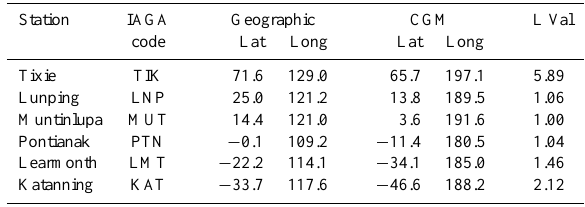
Table 1. Location of 190 ◦ magnetometer stations used in this study.